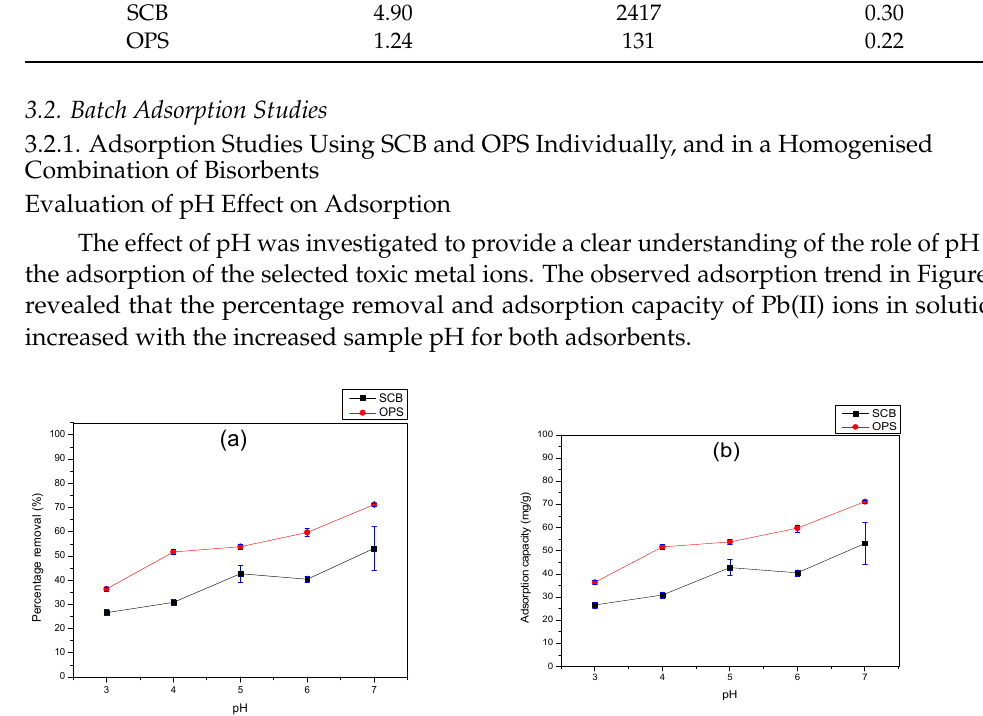
Figure 8. Effect of pH: ( a ) 50 mg/L Pb(II) percentage removal and ( b ) 50 mg/L Pb(II) adsorption capacity.